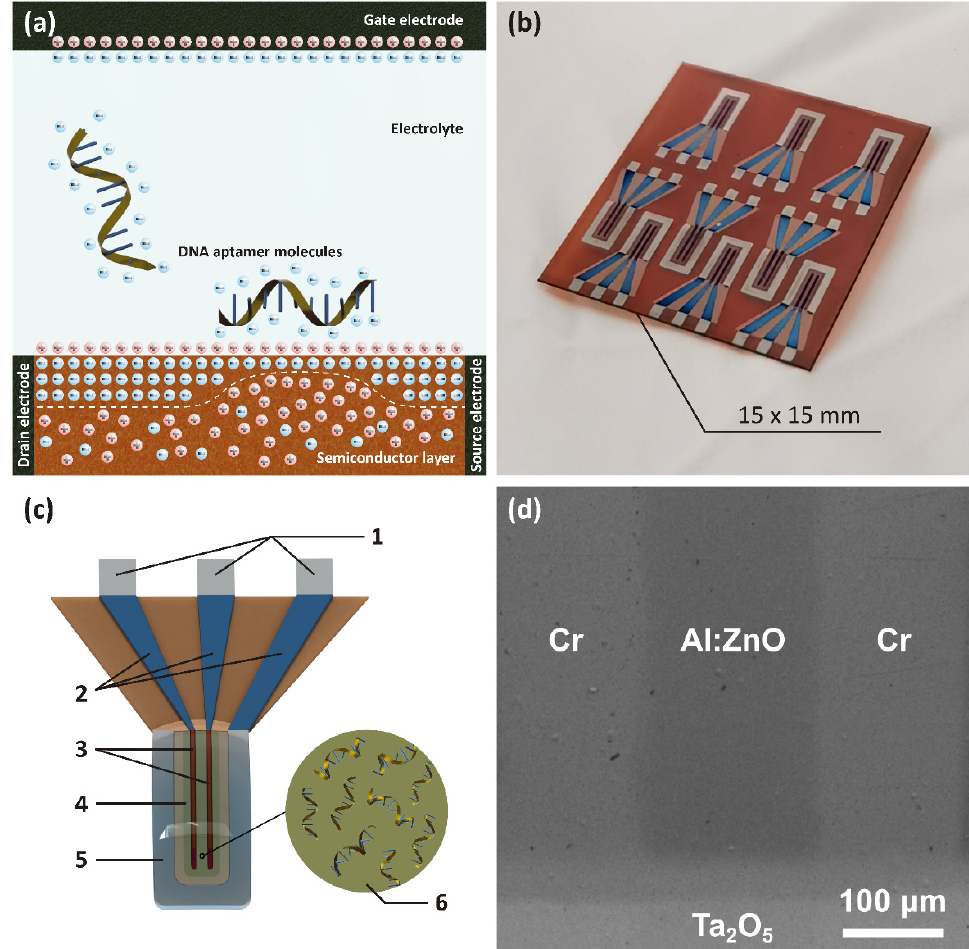
Figure 1. ( a ) Schematic representation of the principle of operation of bio-FET. ( b ) A photograph of the actual polyimide substrate hosting an array of 9 WGFETs. ( c ) A schematic of a single device unit: 1—gate, source and drain contact pads; 2—gate, source and drain electrodes passivated with Ta 2 O 5 ; 3—Al:ZnO layer on top of the drain-source channel; 4—Al:ZnO layer; 5—the gate electrode, 6—DNA aptamers attached to the Al:ZnO surface. ( d ) SEM image of the transistor channel dimension measurements.